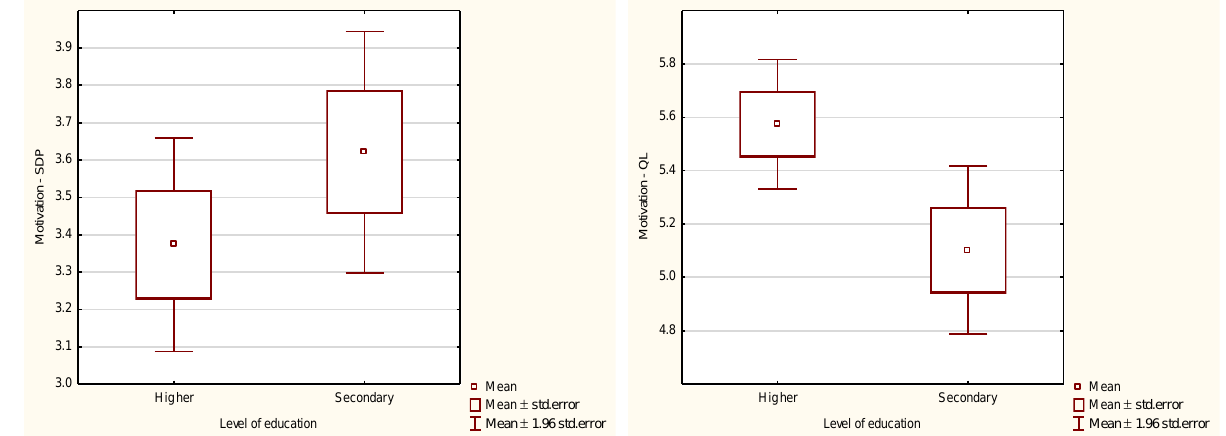
Figure 17. SDP and QL as factors influencing mobility choice at different education levels.